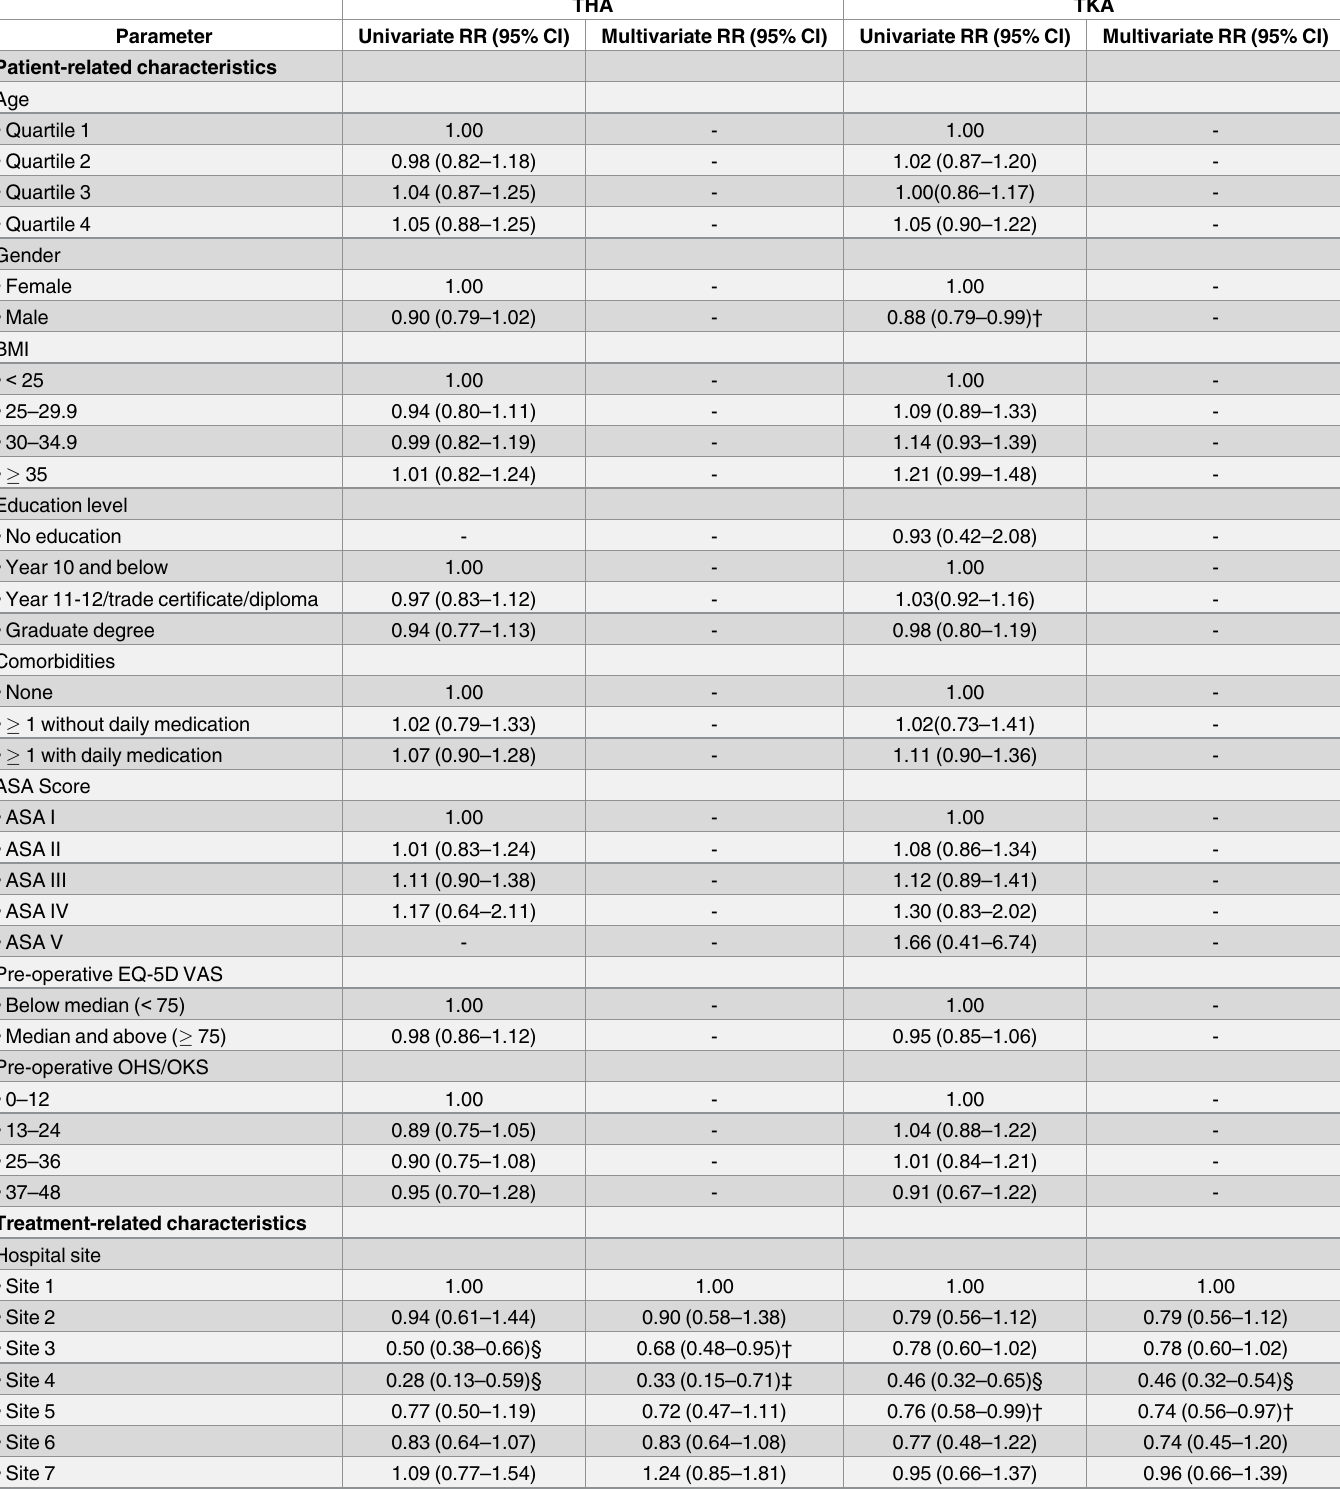
Table 3. Poisson regression analyses for factors associated with time to mobilisation *